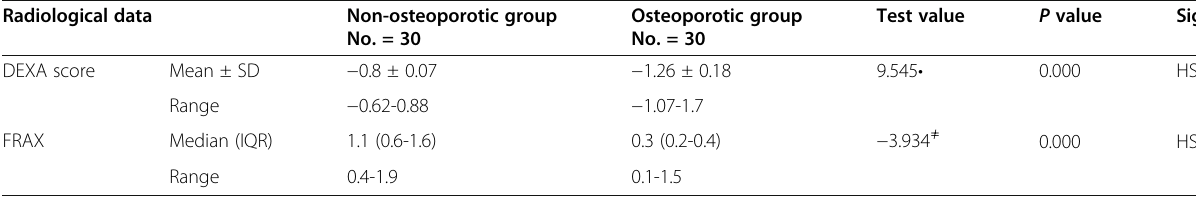
Table 2 Comparative statistics between the 2 groups regarding radiological data Radiological data Non-osteoporotic group